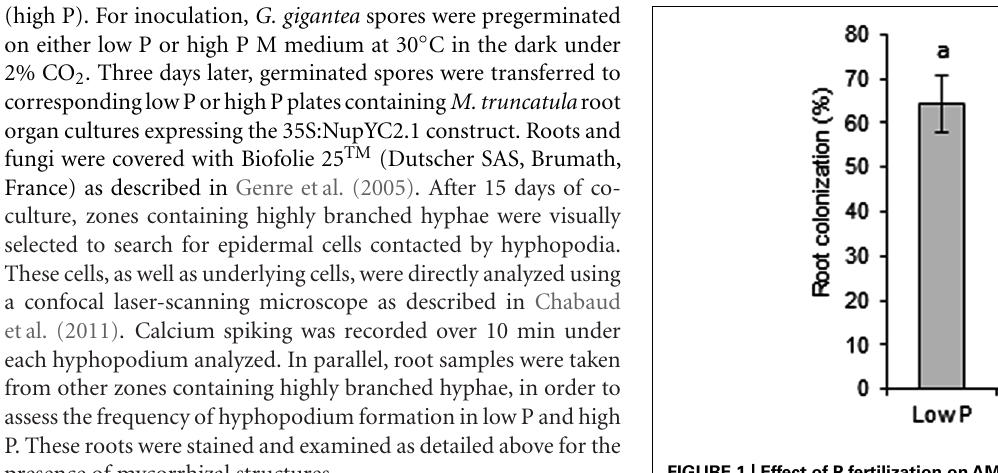
FIGURE 1 | Effect of P fertilization onAM root colonization of M. truncatula. Plants were inoculated with spores of R. irregularis and fertilized with low P or high P nutrient solutions containing 0.0075 or 3.75 mM Pi, respectively.The extent of root colonization was determined 5 weeks post-inoculation after observation of stained root samples, and is shown as the fraction of the root length with arbuscules, vesicles, or both. Error bars represent SEM. n = 6 plants per condition. Different letters indicate a statistically significant difference according to the unequal variance t -test ( P <